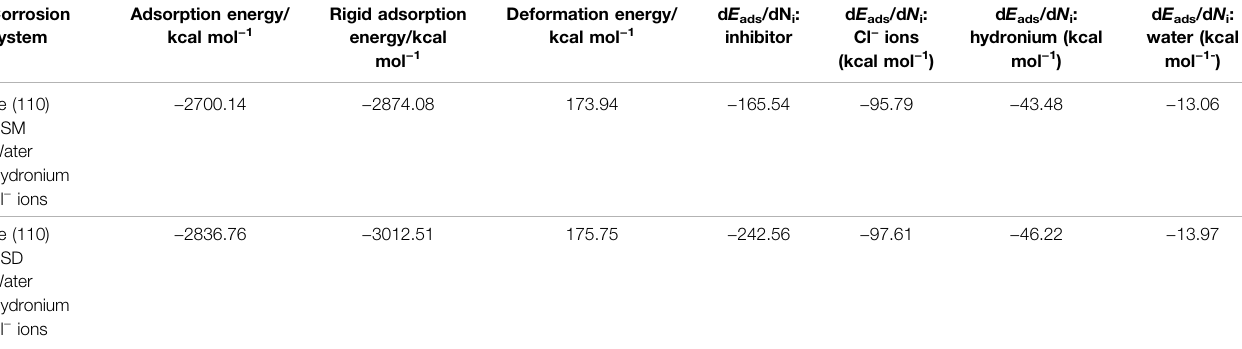
TABLE 4 | Data and descriptors calculated by the Monte Carlo simulation (MC) for the adsorption of the structure CSM and CSD surfactants on Fe (1 1 0). Corrosion